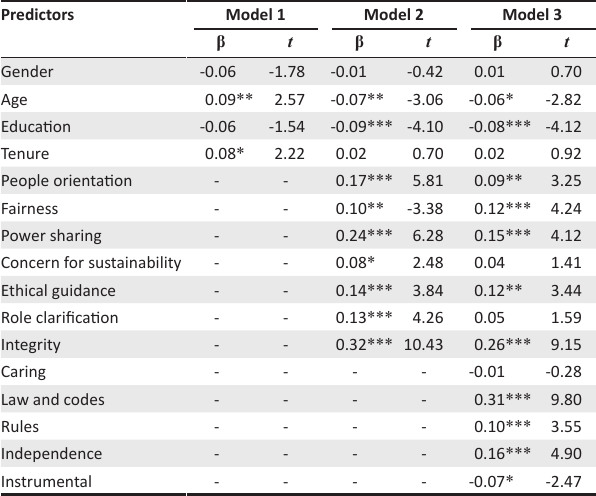
TABLE 2: Results of hierarchical regression. Predictors